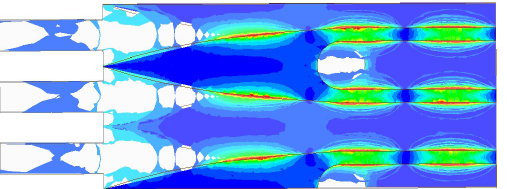
FIGURE 7. The Symmetry of the currents inside the Triple Finline, induced by P-QWT.